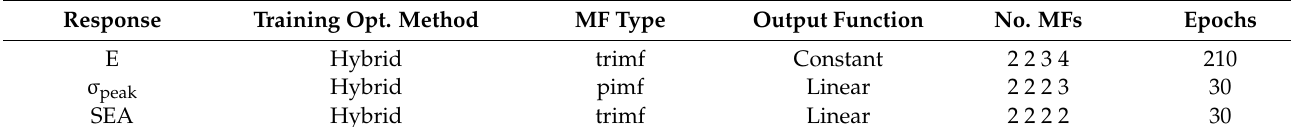
Table 10. Fuzzy inference parameters settings.